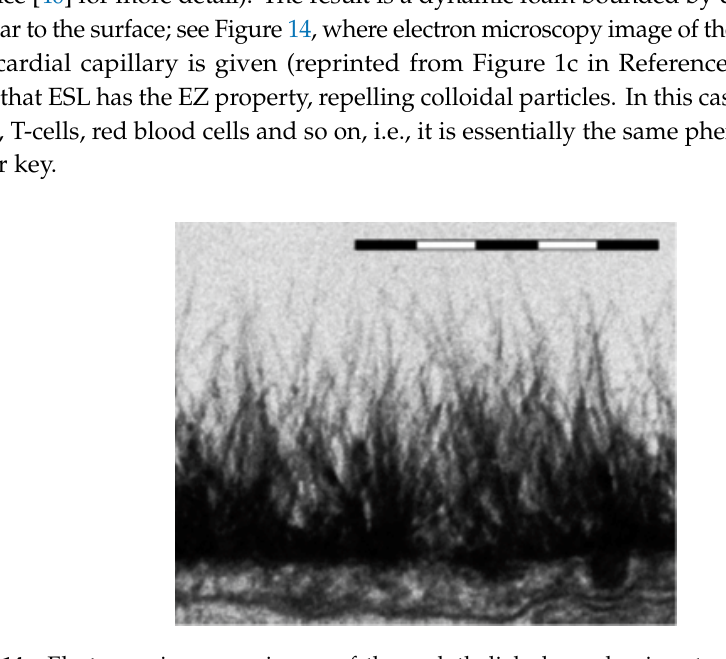
Figure 14. Electron microscopy image of the endothelial glycocalyx in rat myocardial capillary; reprinted from Figure 1c in Reference [42]. Bar above image is 0.5 μm. Reprinted with permission from H. Vink et al., Copyright 2003 AHA Journals.